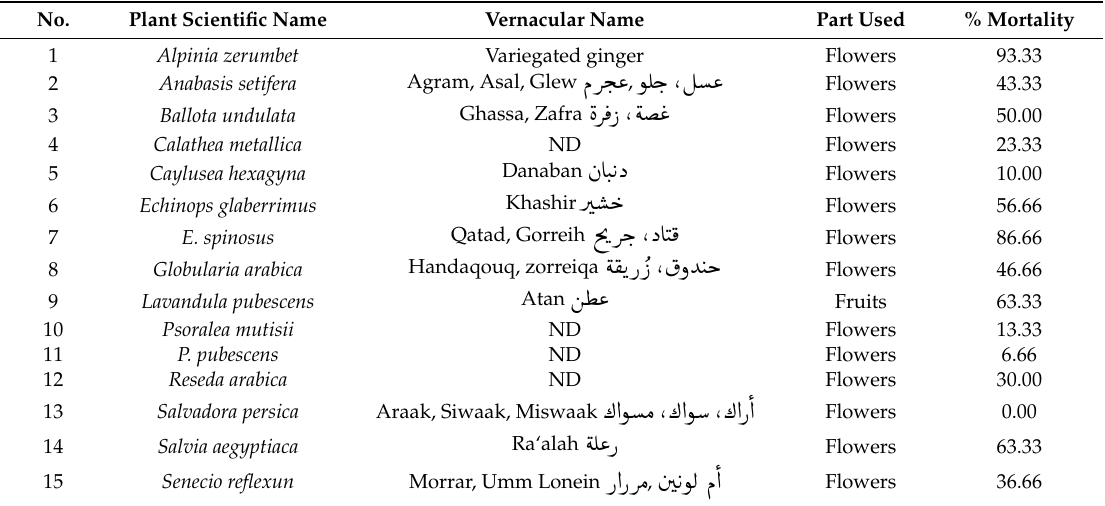
Table 1. Lethality of Egyptian medicinal plants’ MeOH extracts using brine shrimp ( Artemia salina ).